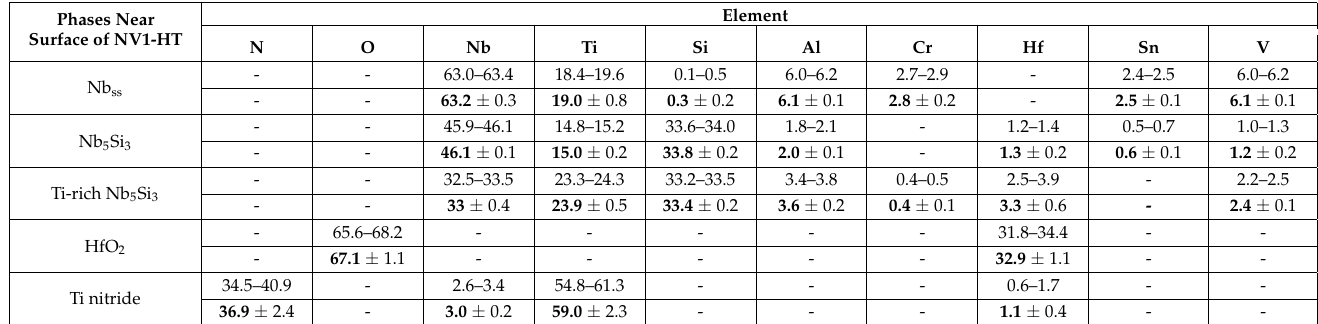
of irregular shape and various sizes had formed near the surfaces of NV1-HT specimens (Figure 2c), up to about 1 mm below the surface. Table 3. EPMA data (at.%) of the phases in the microstructure near the surface of NV1-HT (1500 ◦ C/100 h). (Average values are shown in bold numbers).